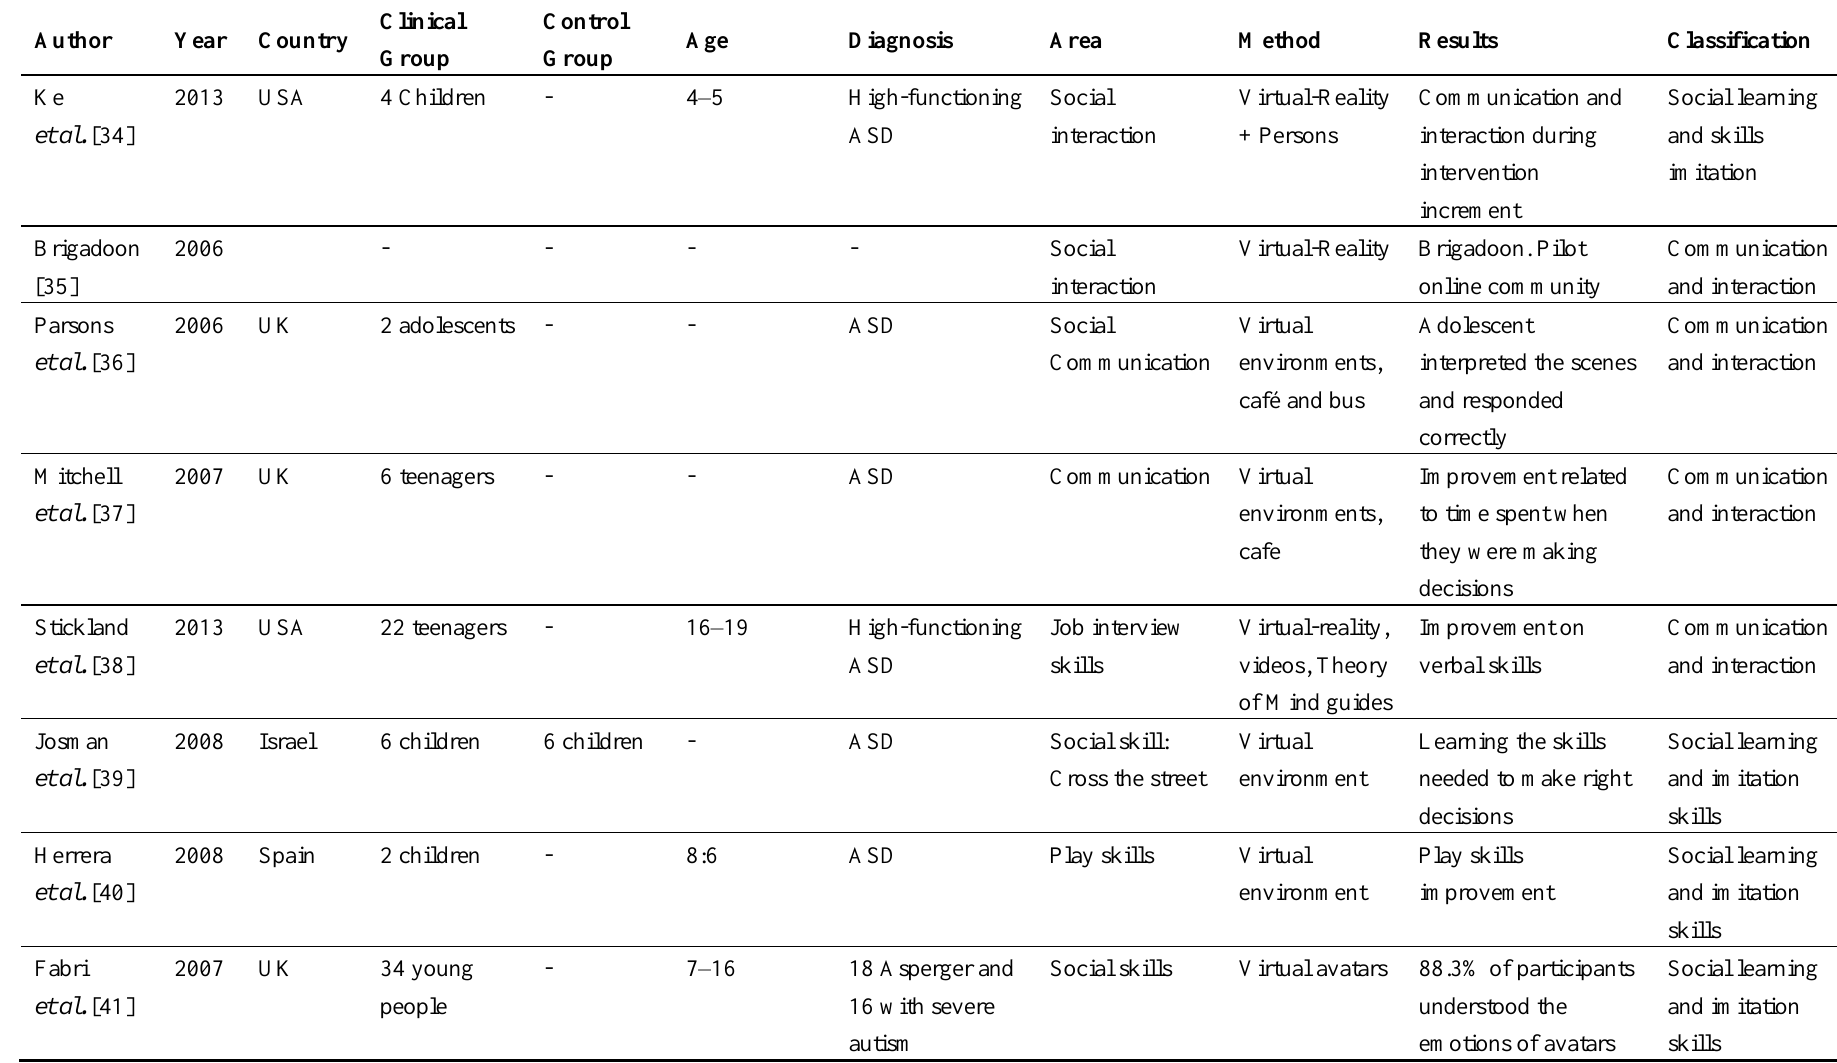
Table 1. Studies on mixed reality